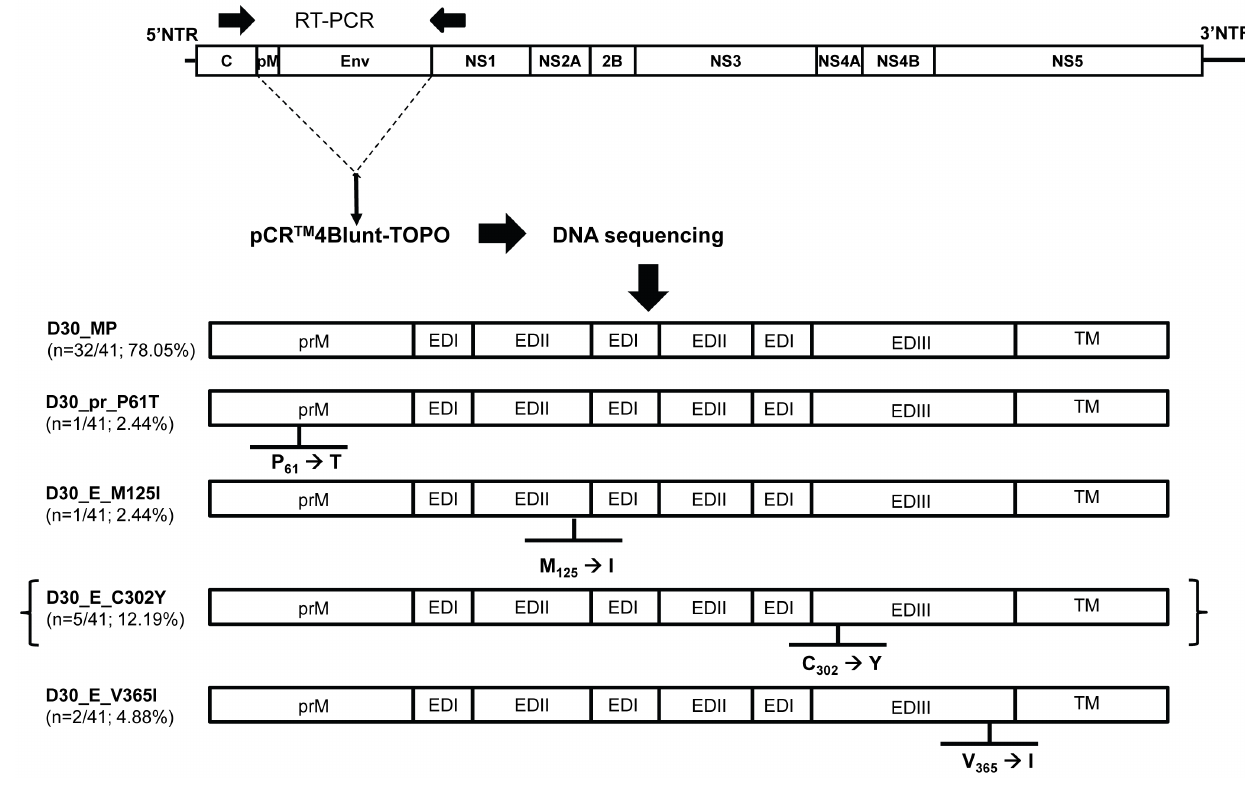
Figure 1. Construction of recombinant DENVs based on virus samples from patient plasma. RNA was extracted from the plasma of patient D30 and the prM-E encoding region of DENV was amplified by RT-PCR and cloned into the pCR4Blunt-TOPO vector for DNA sequence analysis. Representative prM-E region variants were selected and used to construct full-length DENV cDNA clones based on plasmid pmMW/R05-624. The resultant full-length cDNAs containing D30-derived variants were used as templates for RNA synthesis, and in vitro -transcribed viral RNAs were transfected into C6/36 cells. Supernatants from transfected cells were passaged once in C6/36 to obtain adequate quantities of viruses. EDI, envelope domain I. EDII, envelope domain II. EDIII, envelope domain III. TM, transmembrane. The recombinant DENV clone in brackets was excluded from further study due to an inadequate titer.